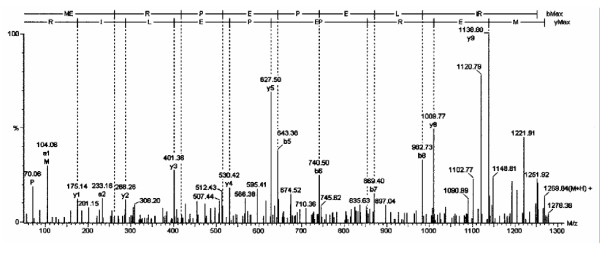
The tandem mass spectrum is shown for the neuroglobin amino acid 1 to 10 peptide. In this and the following figures, the top line represents the b-series, and the 2nd line the y-series. The x-axis presents M/z and the y-axis signal intensity. The numbers are the M/z values for each daughter ion (vertical lines).